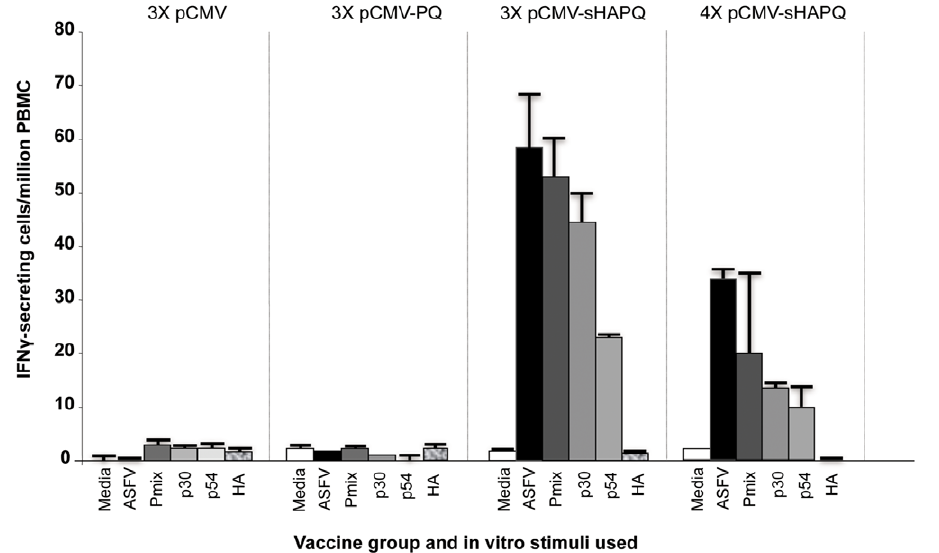
Figure 3. pCMV-sHAPQ induces specific T-cell responses in pigs. PBMCs obtained before ASFV challenge from pigs immunized with pCMV, pCMV-PQ or pCMV-sHAPQ (immunized three or four times), were in vitro stimulated with media (negative control), with the E75 ASFV isolate (10 5 HAU 50 /ml), with a mix of the p54, p30 and HA ASFV proteins (6 m g/ml of each one) or with each one of these proteins individually. Values shown correspond to the average number of IFN c -secretory cells detected per million of PBMCs. Standard deviations found within each group are also represented.